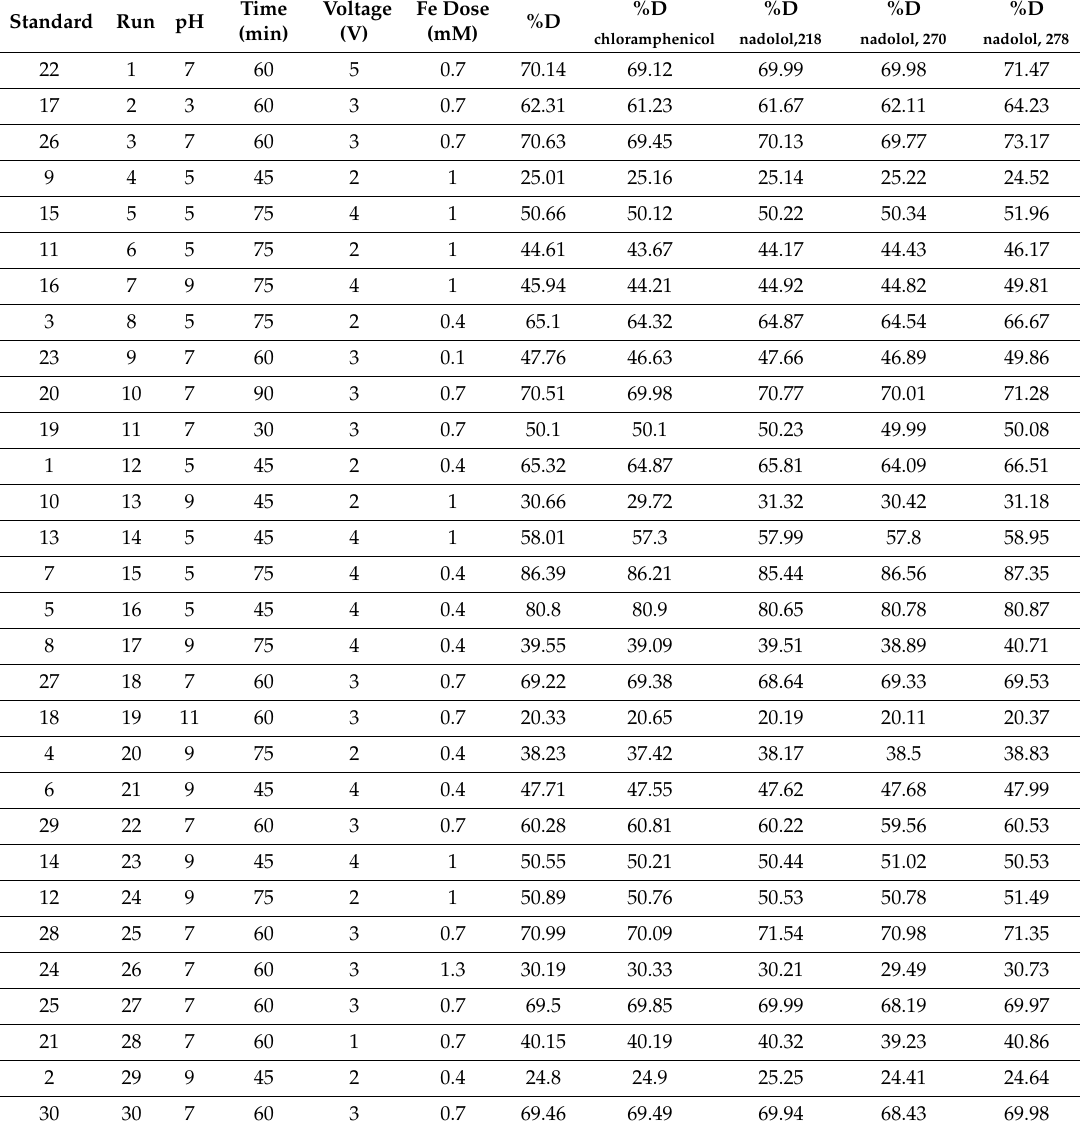
Table 2. Design of an experimental set for the PEF